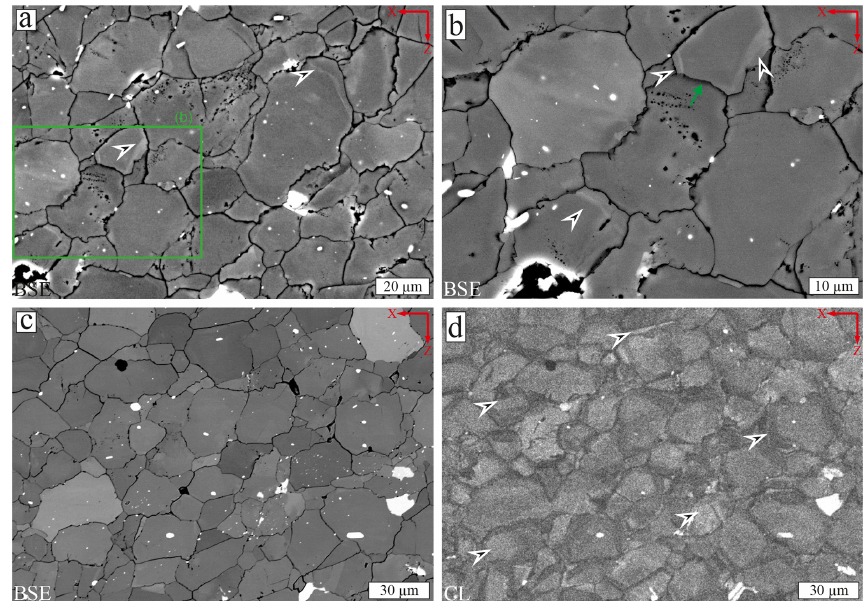
Figure 11. Type A matrix, sample FH5. (a, b) BSE images show albite matrix with irregular grain boundaries, porosity and weak zonation (black arrows). In panel (b) , the zonation of the grain in the upper right is truncated, possibly by growth of the grain below (green arrow). (c) BSE image with grey shades representing both orientation and compositional contrast (bright phase is apatite) and (d) corresponding CL image showing zonations, not visible in the BSE image (arrows). Grain boundaries in the CL image are also associated with darker grey